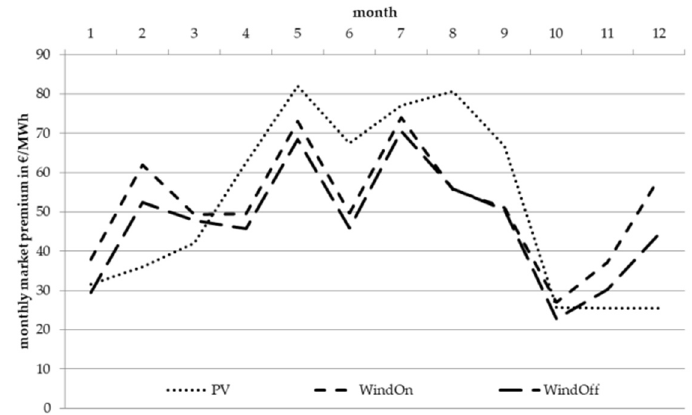
Figure A7. Development of the market premium for PV, wind onshore and wind offshore in the extended storage scenario.